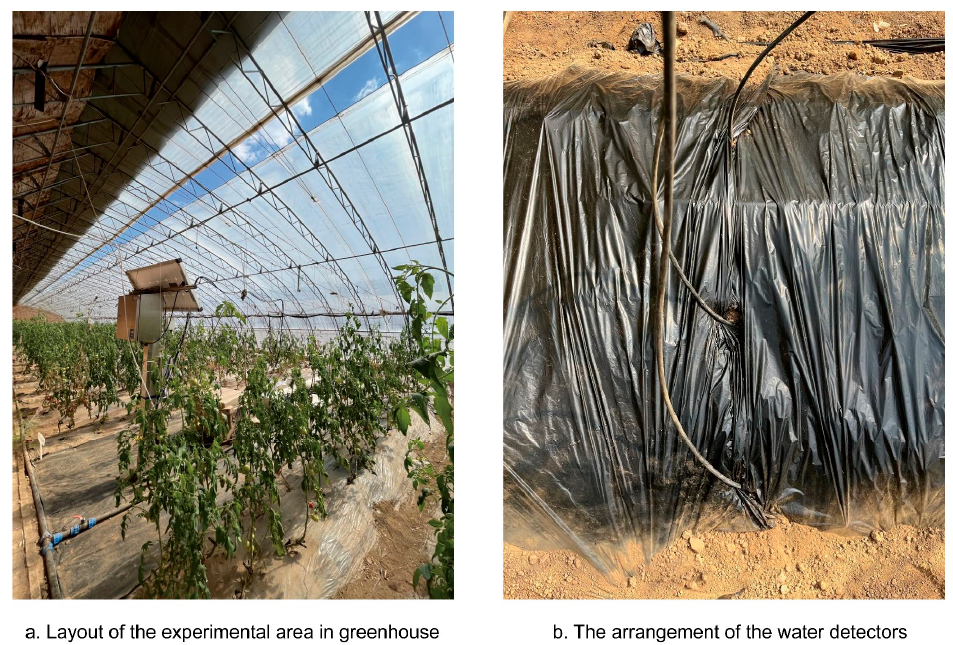
Figure 1. The arrangement of the experimental area in the greenhouse.